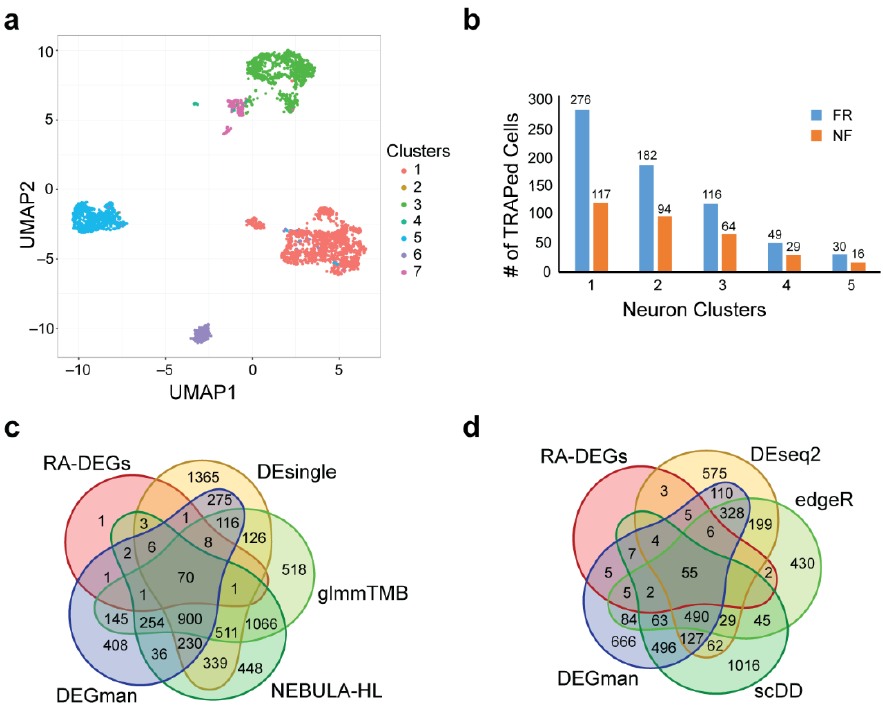
Figure 3. Comparative analysis of DEGs among mouse neurons. ( a ) UMAP dimensional reduction of the clustering result of all Snap25 + neurons (3530 cells). ( b ) The numbers of TRAPed FR and NF cells in the five largest clusters. ( c ) Venn diagram of the DEGs called by DEGman, DEsingle, glmmTMB and NEBULA-HL under an adjusted p -value of 0.05. ( d ) Venn diagram of the DEGs called by DEGman, DEseq2, scDD and edgeR under an adjusted p -value of 0.05. Among DEGs that are detected by DEGman from TRAPed FR and NF cells in the five largest clusters, there are 25 DEGs found in common including several ATPases, synapsins and several predicted genes (Table S3). The heatmap of the 25 DEGs showed a clear difference between TRAPed FR and NF cells (Figure 4a). Hierarchical clustering analysis shows that they can be divided into three gene clusters: cluster 1 shows lower expression levels in FR neurons and higher expression levels in NF neurons, while cluster 2 and 3 have higher expression levels in FR neurons and lower expression levels in NF